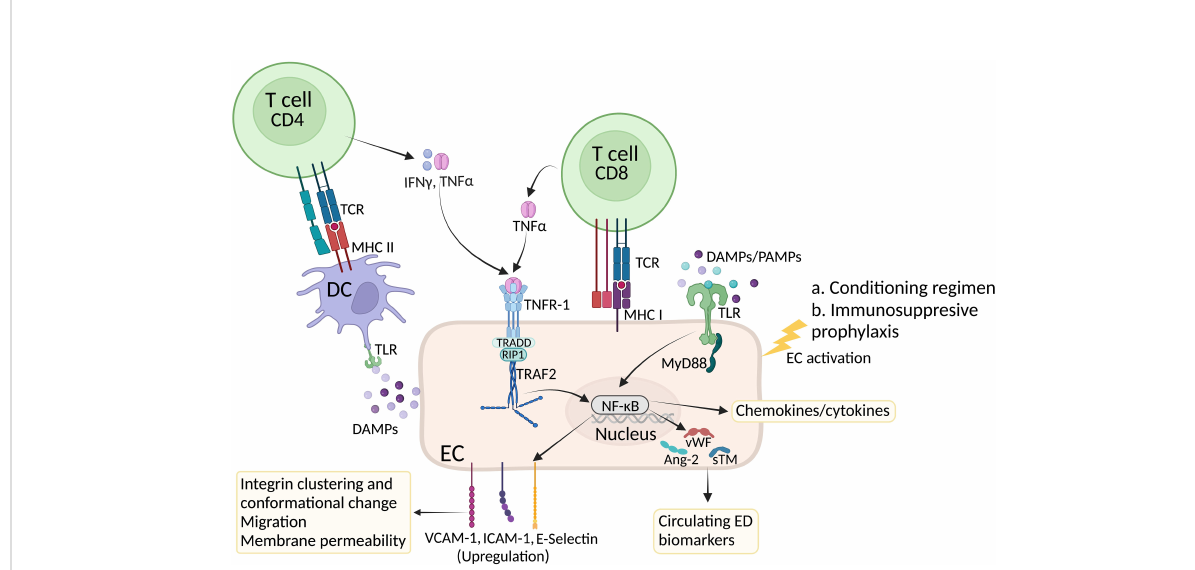
FIGURE 1 Factors affecting EC activation in GVHD. High dose chemotherapy induces systemic in fl ammation and endothelial cell damage. In response to in fl ammatory cytokines and Damage Associated Molecular Patterns (DAMPs), ECs undergo activation and express E and P selectins as well as VCAM-1 and ICAM-1 integrins to recruit innate and later adaptive immune cells at the in fl ammatory site. Inside the lymph node, presentation of allogeneic peptides by host dendritic will induce activation of CD4+ and CD8+ T cells. While cytotoxic CD8+ T cells further damage ECs, release of in fl ammatory cytokines such as IFN- g and TNF- a by CD4+ T cells can bind to their receptors on ECs and further contribute to EC activation. In response to damage and activation, ECs produce and secrete von Willebrand factor (vWf) as well as angiotensin 2 (Ang-2) and soluble thrombomodulin (sTM). Circulating levels of these proteins are considered a biomarker of EC injury. Created with